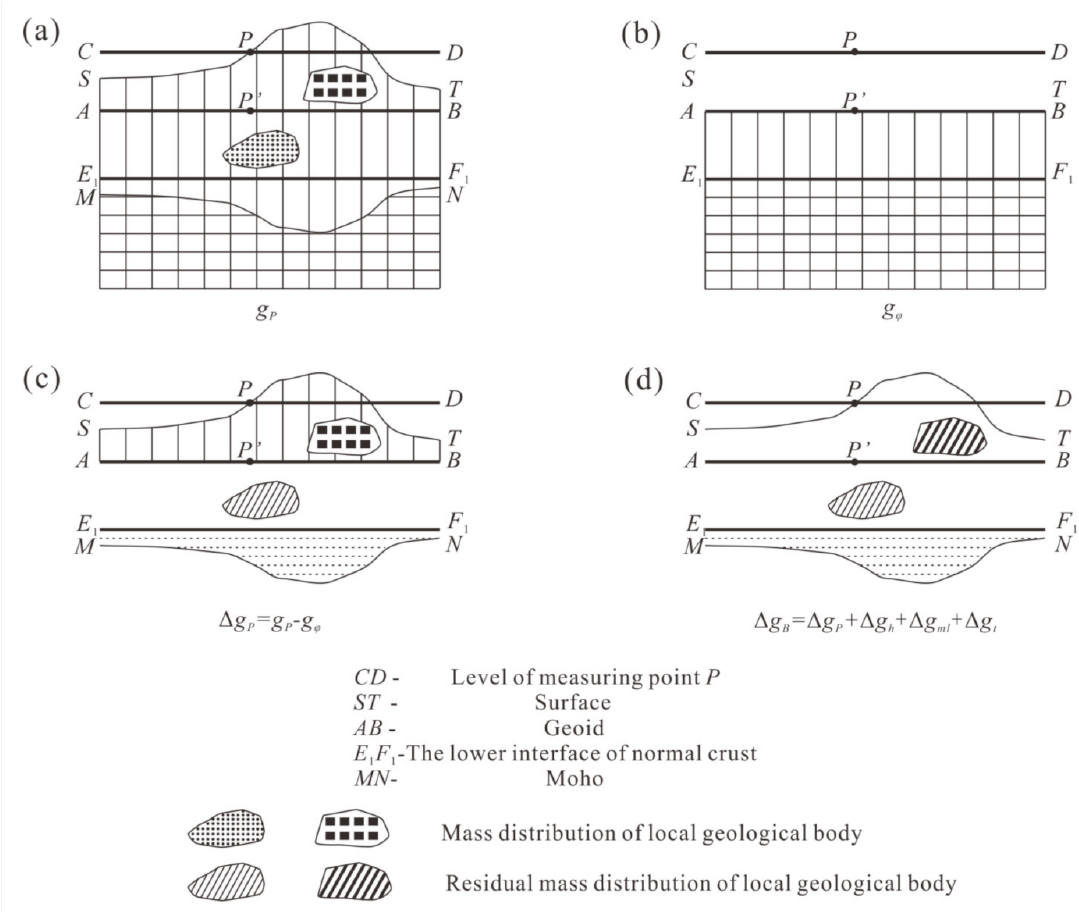
Figure A3. Geological and geophysical significance of various gravity anomalies. ( a ) Absolute gravity of P ; ( b ) Normal gravity field; ( c ) Correction of normal gravity field; ( d ) Bouguer